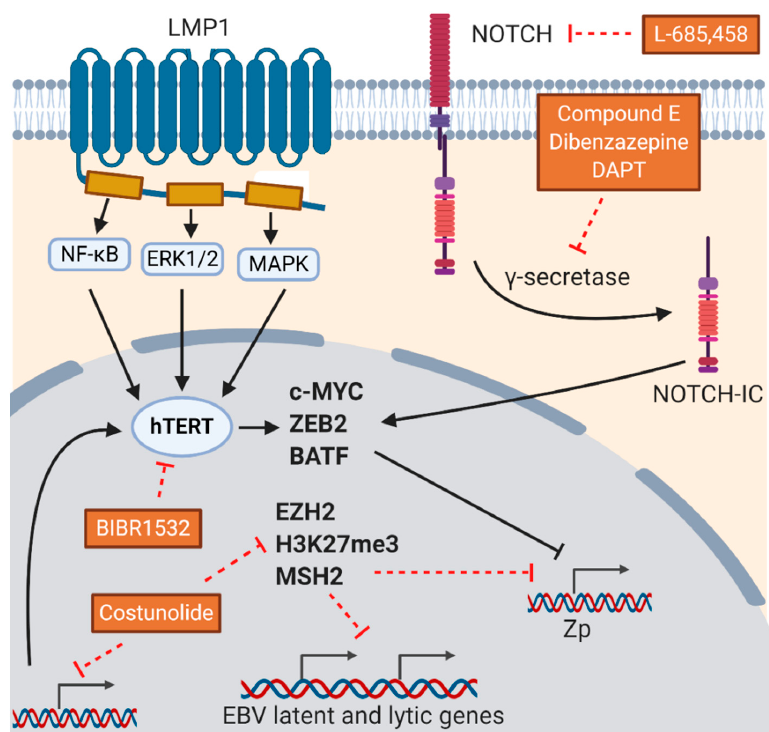
Figure 5. Relationship between EBV proteins, hTERT, and NOTCH signaling pathway and the modes of action of compounds with lytic induction potentials. hTERT inhibits the expression of BZLF1 through the NOTCH2 / BATF pathway. EBNA2 is regarded as the functional homolog of active NOTCH intracellular domain (Notch-IC) and LMP2A can activate the NOTCH pathway. NOTCH2 inhibits